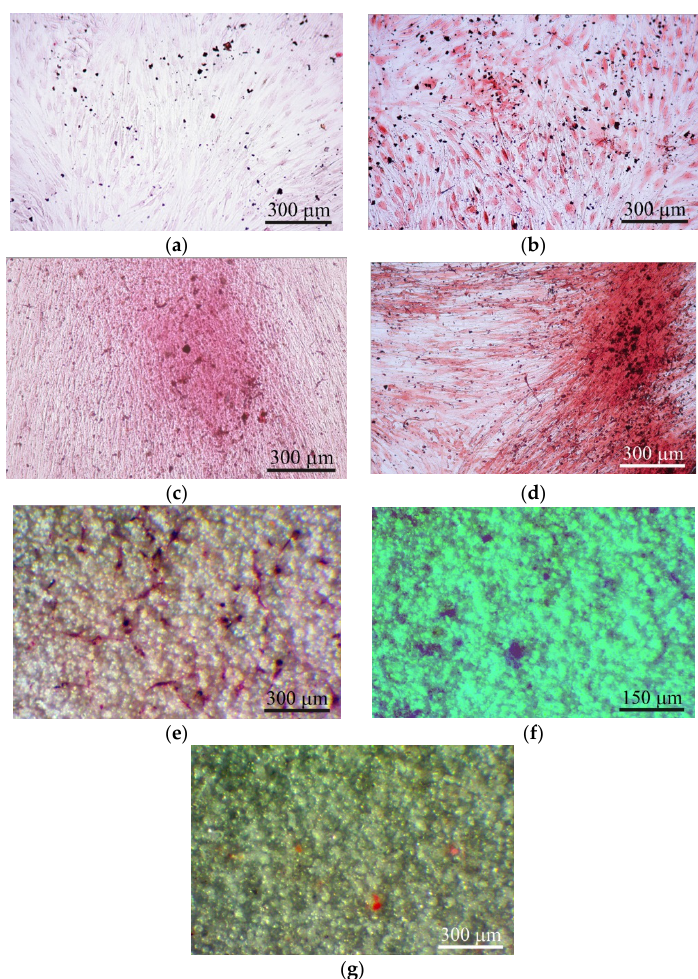
Figure 5. hAMSC culture after 21 days of culture on plastic surface ( a )–( d ) and on the rough CaP coating ( e )–( g ) in a standard nutrient medium . ( a ) 2D culture of hAMSCs; ( b ) culture of hAMSCs around CaP ‐ coated specimens; ( c ) mixed 2D culture of hAMSCs+hBMNCs; ( d ) mixed 3D culture hAMSCs+hBMNCs around CaP ‐ coated specimen; ( e ) Sites of the cell and extracellular matrix (ECM) mineralization. Alizarin red staining ( a )–( e ); ( f ) alcian ‐ blue ‐ stained sites of glycoproteins; ( g ) oil ‐ red ‐ stained sites of neutral triglycerides and lipids. Scale bars 150 and 300 μ m. Alizarin red staining of individual cells did not allow us to calculate the area of ECM mineralization in hAMSC monocultures (Table 2). Staining appeared when hBMNCs were added to hAMSCs (Table 2; Figure 5c), and a 10 ‐ fold increase in the total area of ECM mineralization around the CaP ‐ coated samples was detected in the mixed culture (Table 2; Figure 5d).